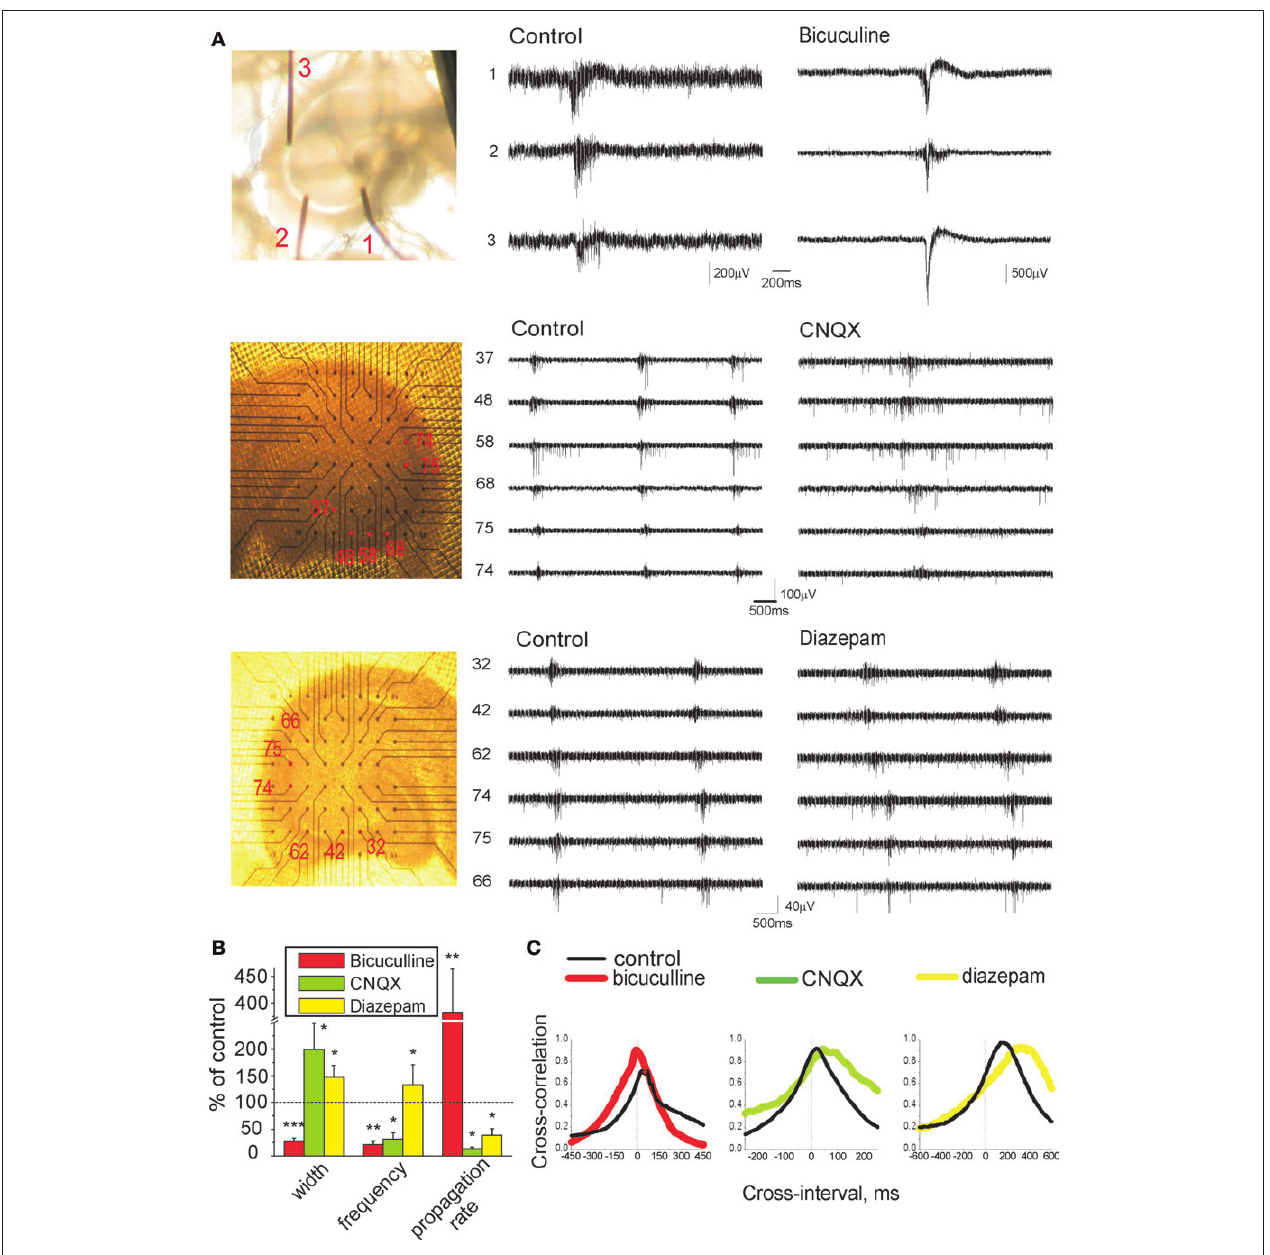
Figure 8 | effects of drugs modulating efficacy of gABAergic and glutamatergic transmission on network synchronization during gDPs. (A) Left: recording field electrodes arrangement in pyramidal layer of hippocampus for concomitant recordings from different sites. Middle and right: traces representing extracellular GDP recordings in control conditions and after drug application (top traces, 3 μM bicuculline; middle traces, 1 μM CNQX;